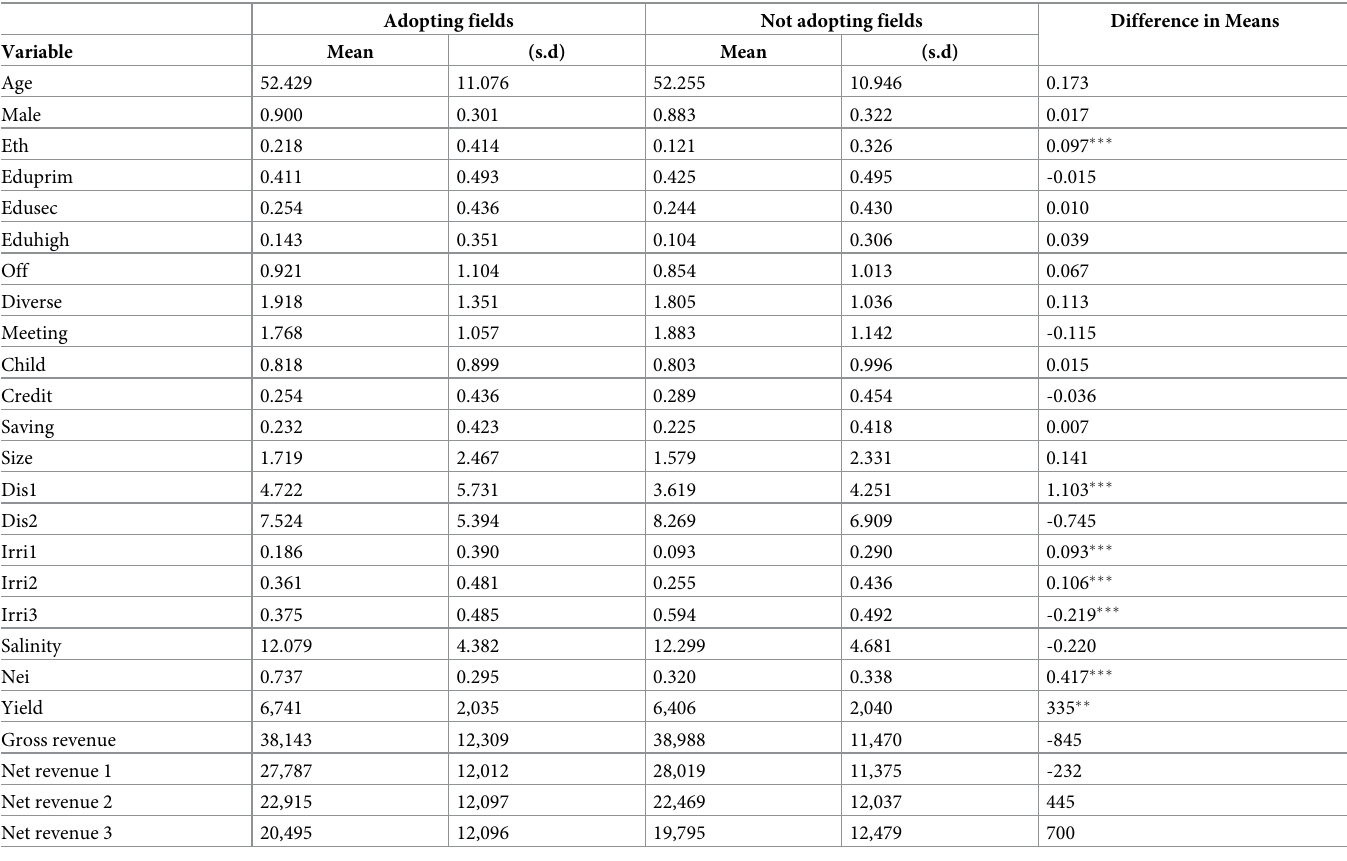
Table 4. Descriptive statistics for fields adopting and not adopting CURE-related varieties, 2017–2018 Dong Xuan